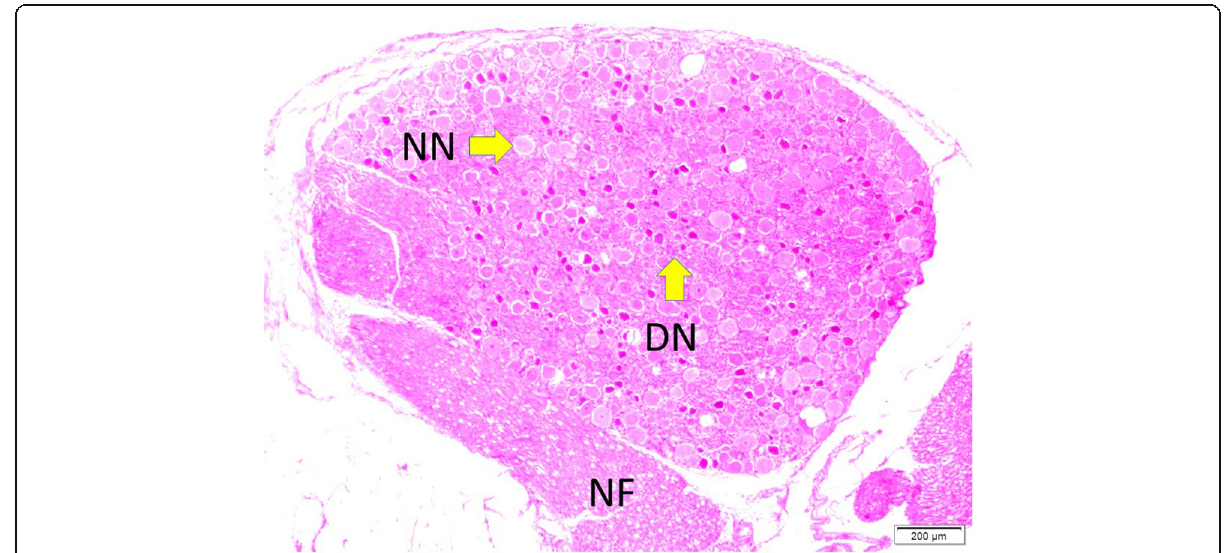
Fig. 6 Histopathological appearance of DRG with normal (NN) and degenerated (DN) neurons and nerve fibres (NF) are seen in an animal that underwent surgical circumcision